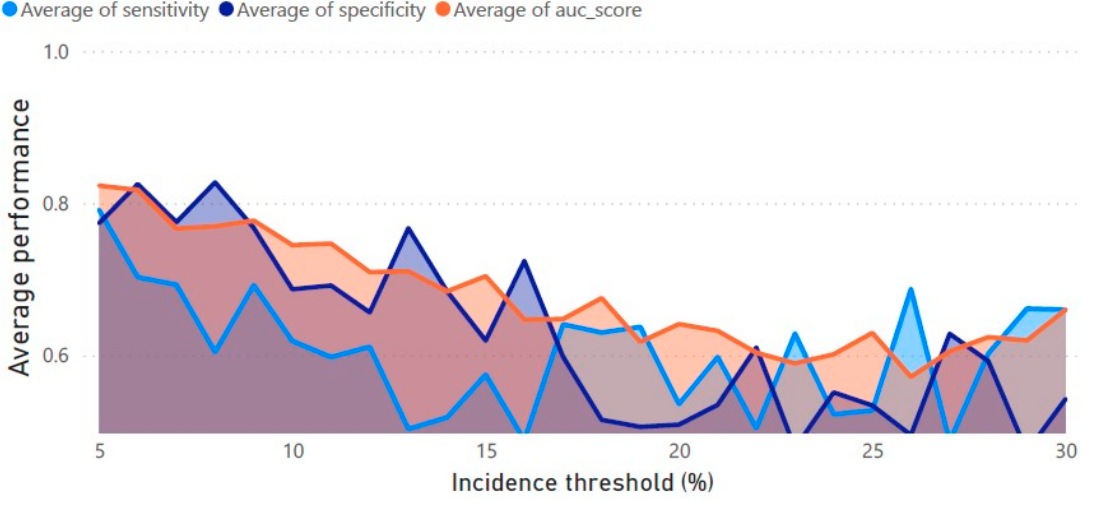
Figure 7. Area chart presenting the average performance (orange), sensitivity (light blue), and specificity (dark blue) of all tested classification algorithms for each tested stress incidence threshold.